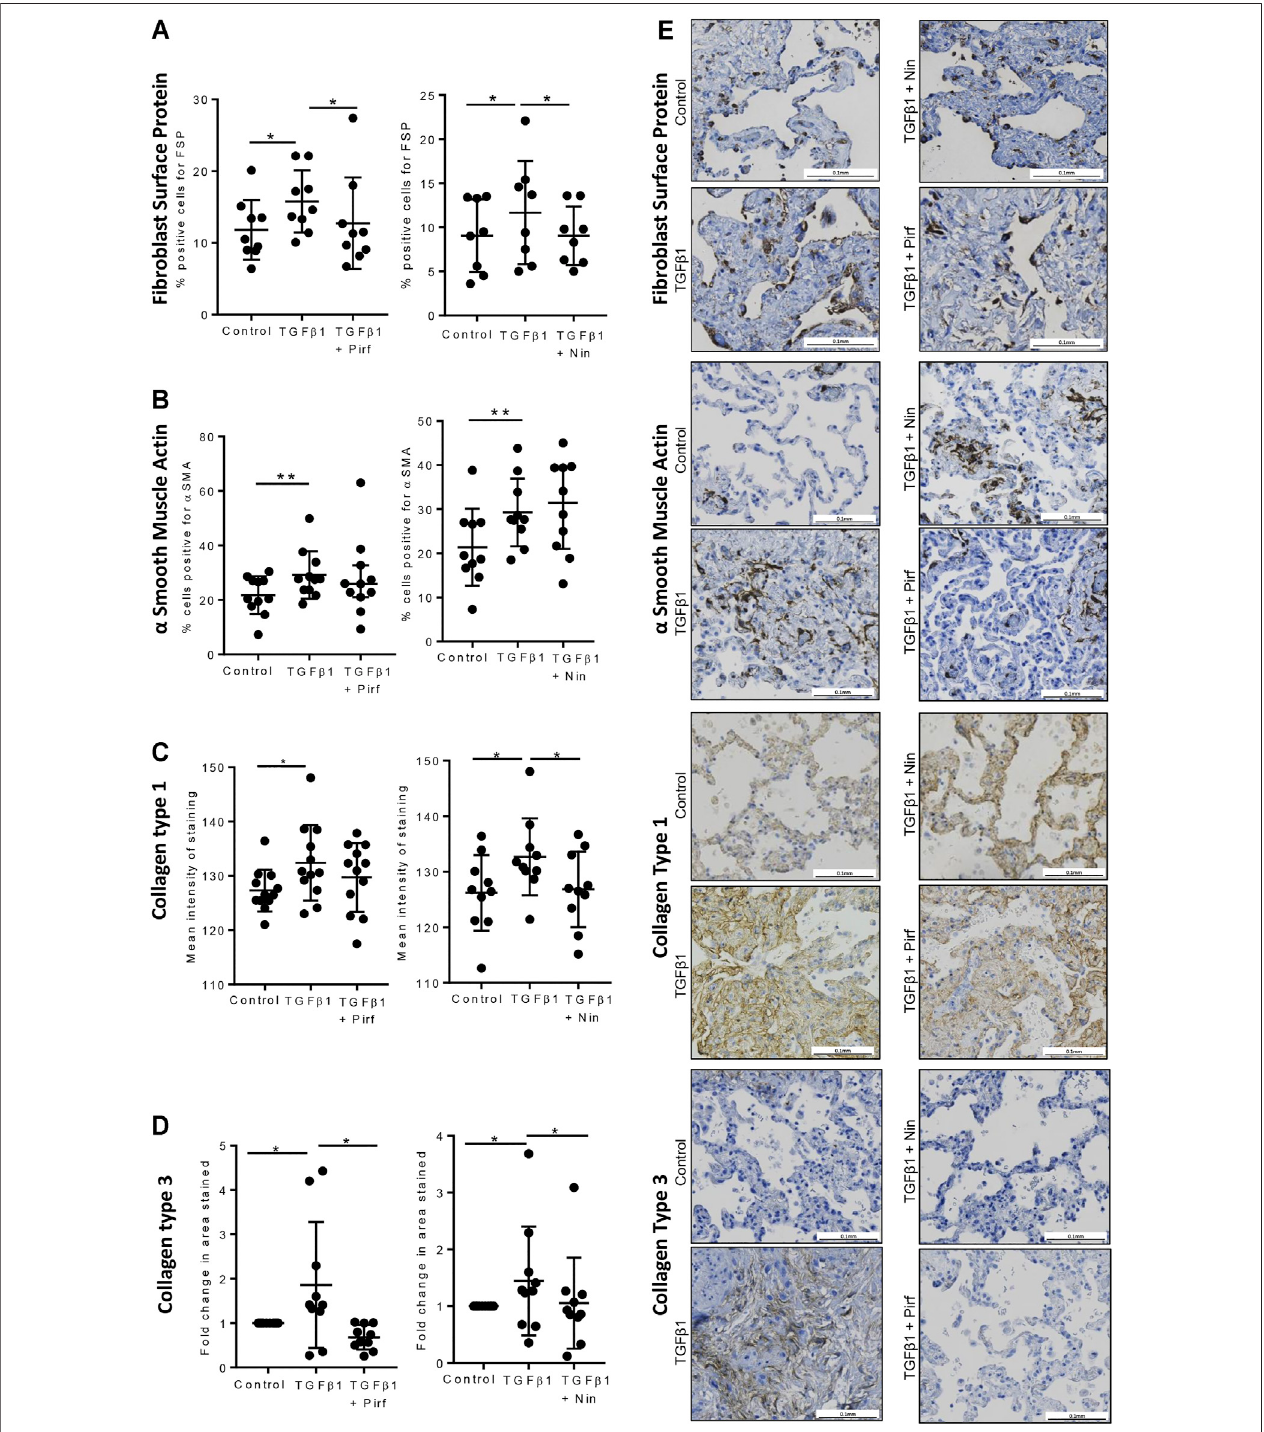
FIGURE 7 | Immunohistochemical staining for FSP + fi broblasts, α SMA, collagen type 1, and collagen type 3, following lung tissue exposure to TGF β 1, with or without nintedanib (1 µM) or pirfenidone (500 µM) for 7 days. (A – D ) Quanti fi cation of immunohistochemical staining. Nintedanib signi fi cantly attenuated FSP ( n (cid:1) 8), collagen type 1 ( n (cid:1) 10) and collagen type III ( n (cid:1) 10) TGF β 1-dependent pro- fi brotic responses within the tissue over 7 days ex vivo culture. Pirfenidone signi fi cantly attenuated FSP ( n (cid:1) 9) and collagen type III ( n (cid:1) 10) TGF β 1-dependent pro- fi brotic responses within the tissue over 7 days ex vivo culture. Data are presented as mean ± SEM* p < 0.05,** p < 0.01. (E )Representativeimmuno-histochemicalimagesof7 days exvivo cultured lungtissueunderthefollowingconditions:un-stimulated control, TGF β 1-stimulated + 0.1% DMSO, TGF β 1-stimulated + nintedanib (1 µM) and TGF β 1-stimulated + pirfenidone (500 µM).